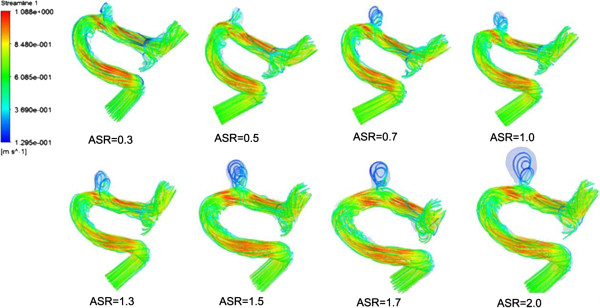
Blood flow streamlines within the aneurysm models at peak systole. The image described the flow velocity, quantity, and vortex in all the scaled models including the original model. Obvious variations could be observed with the changes of ASR.